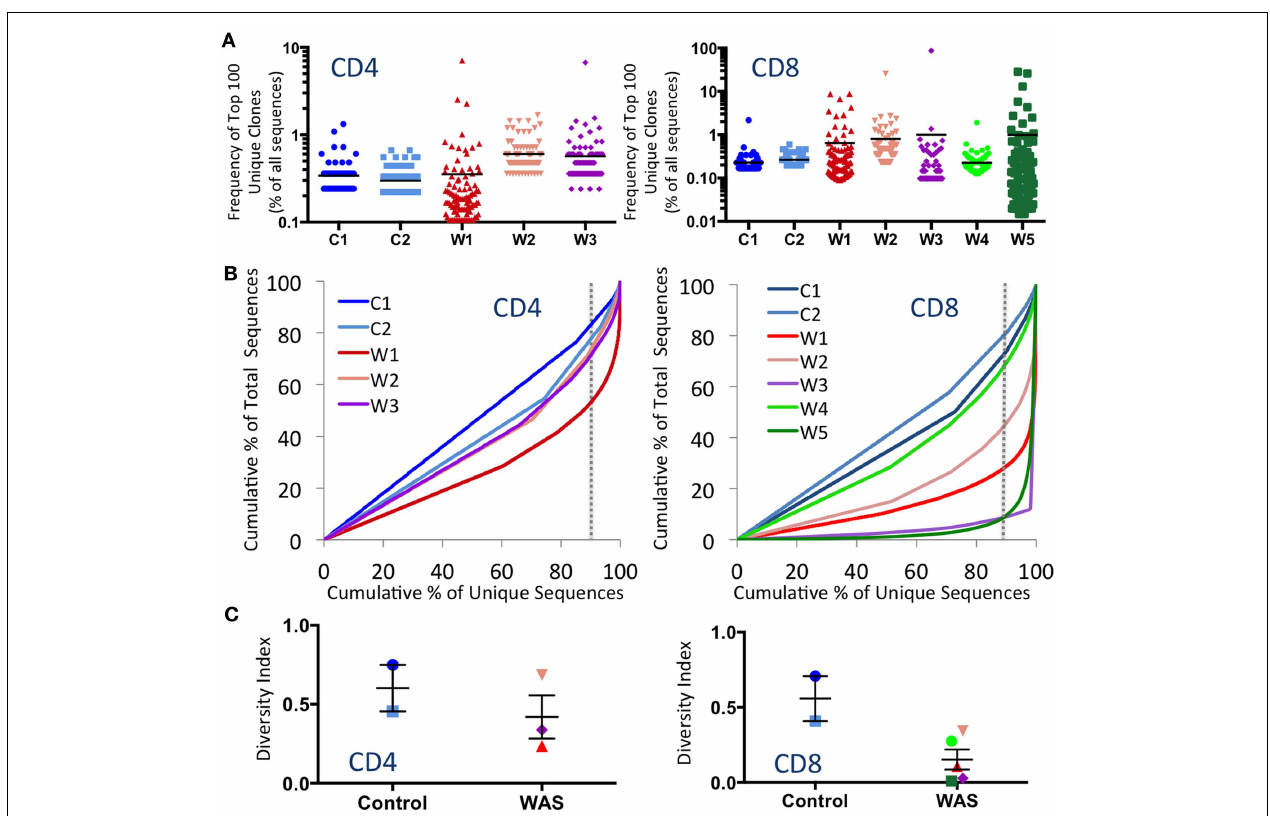
an even distribution of clonotypes.The dotted gray vertical line indicates 90% of cumulative unique sequences, with sequences to the right of the line corresponding to the top 10% most abundant unique clonotypes. (C) The diversity of each patient’s repertoire was determined by dividing the number of unique sequences over the total sequences for CD4 + and CD8 + populations. Bars represent mean and SE. In all panels, the same color is used to identify individual control subjects and